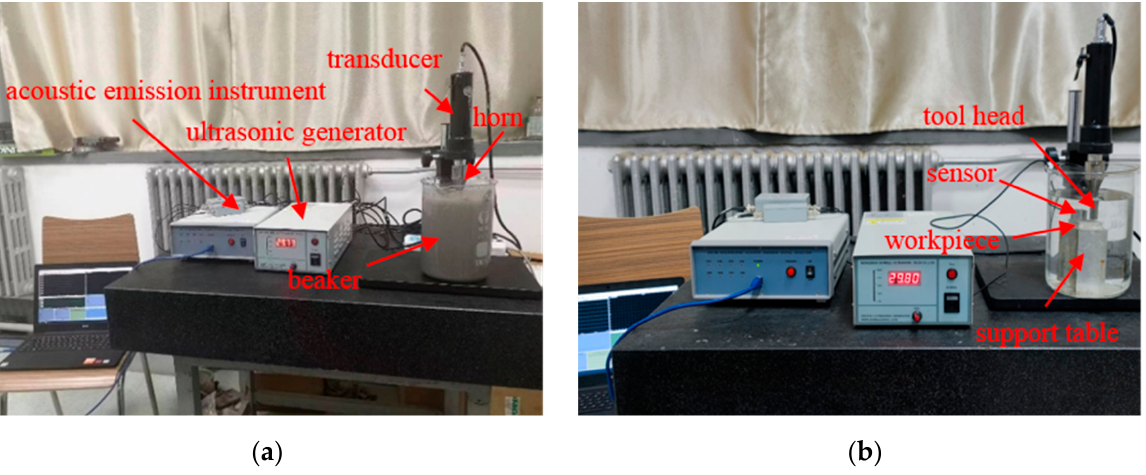
Figure 2. Ultrasonic cavitation experiment platform. ( a ) Abrasive suspensions with different SiC contents; ( b ) Water without SiC.